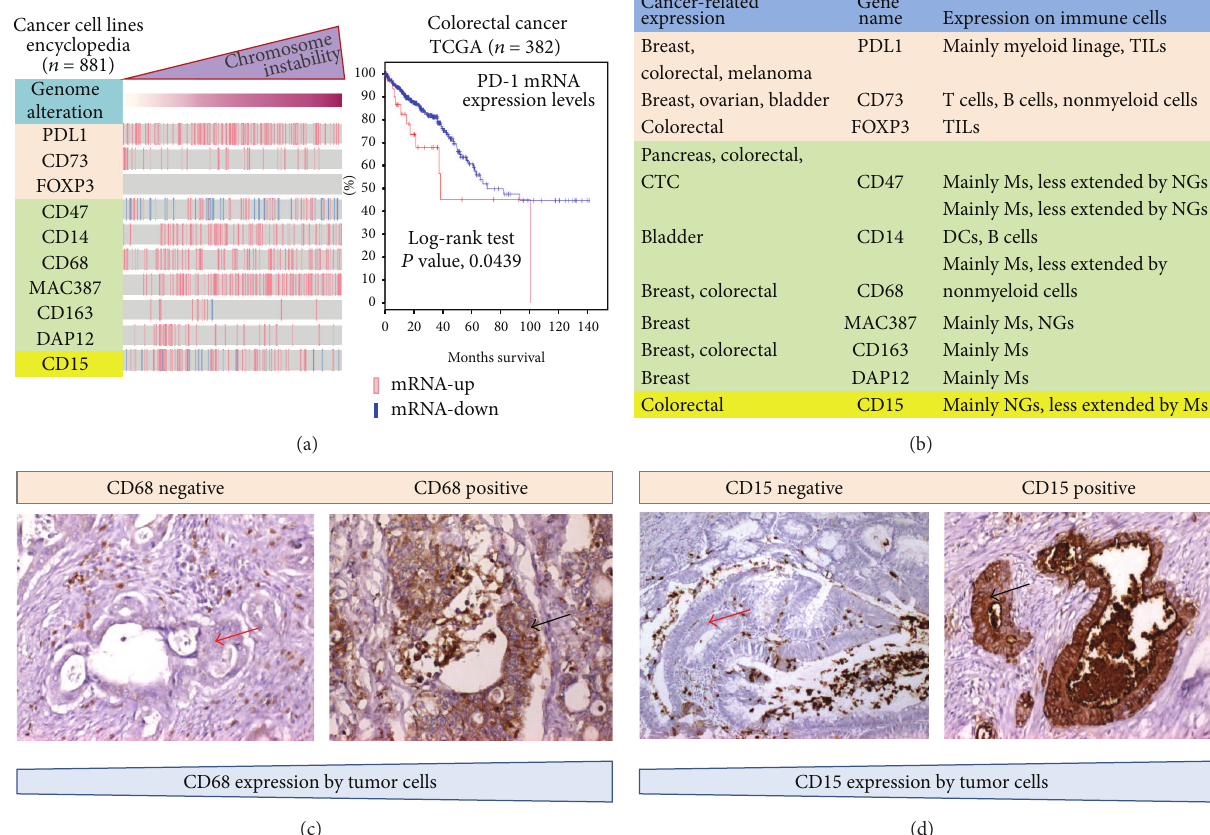
Figure 3: Subsets of immune-phenotypic genes correlate with genome instability in a variety of tumors. (a) Genome instability represents one of the most important hallmarks of genetic diversity in tumors. We utilized a panel of 881 human tumor cell lines derived from different tissues of origin that has been extensively characterized for gene expression and copy-number variations and commonly used for genetic analysis and screening of potential chemotherapeutic agents [21]. mRNA expression of the immune antigens subdivided into low and high is shown. Kaplan-Meier curve shows that, compared with tumors expressing low PD-1 mRNA levels (blue line, 348/382, 91%), tumors with high PD-1 mRNA expression (red line, 34/382, 9%) are significantly associated with poor overall survival by interrogating the public colorectal cancer TCGA data set ( 𝑁 = 382 ). (b) Subsets of immune antigens and their prevalence in cancer cells in solid tumors